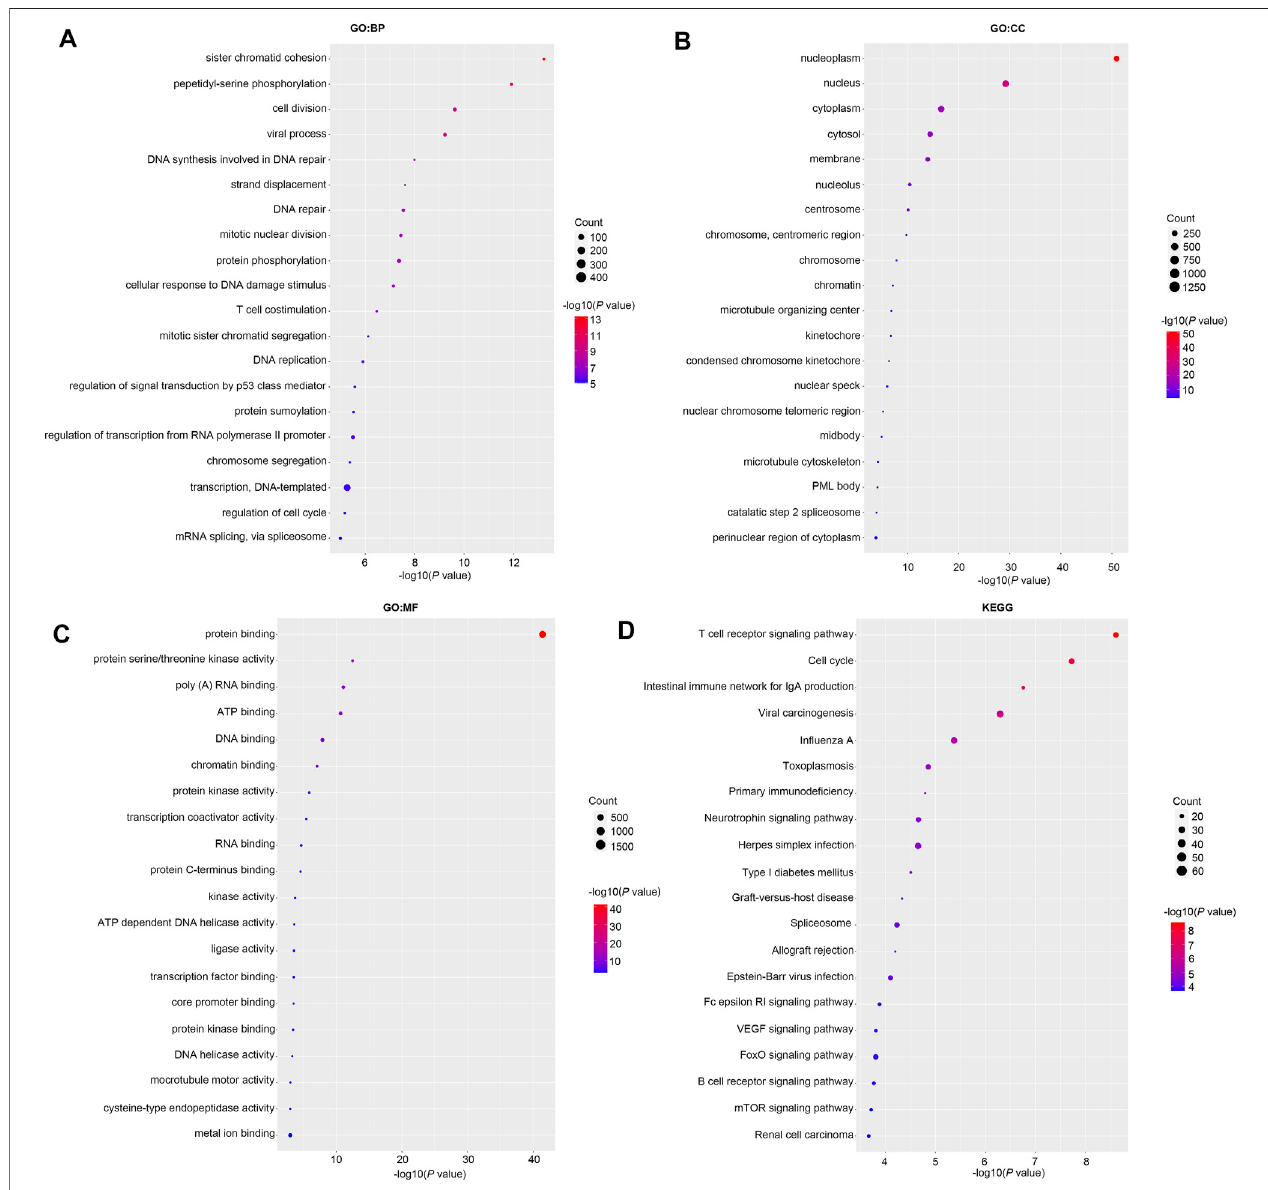
FIGURE 11 | GO and KEGG analysis of 82 co-expression genes of RBM15 alterations in PAAD. (A) GO: BP. (B) GO: CC. (C) GO: MF. (D) KEGG.